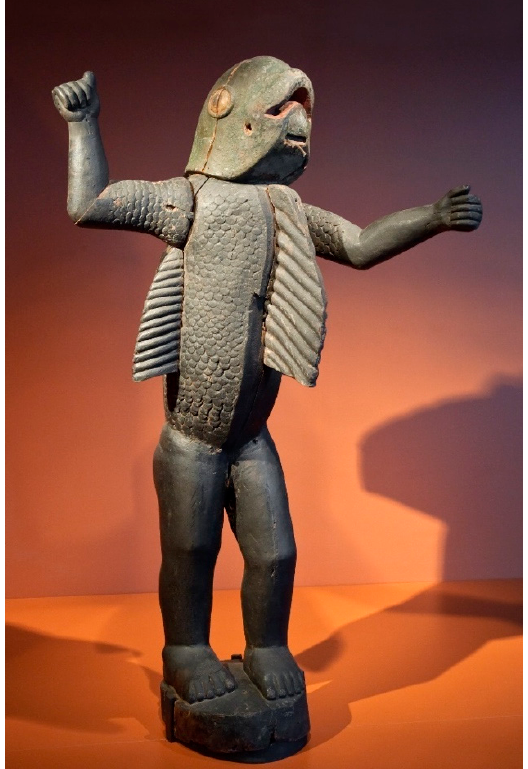
Figure 17. This anthropomorphic royal statue from Dahomey, carved by Sossa Dede between 1889 and 1892, is often labeled “Homme-Requin” (Man-Shark) and thought to represent King Béhanzin. Image courtesy of the Quai Branly Museum, Paris.